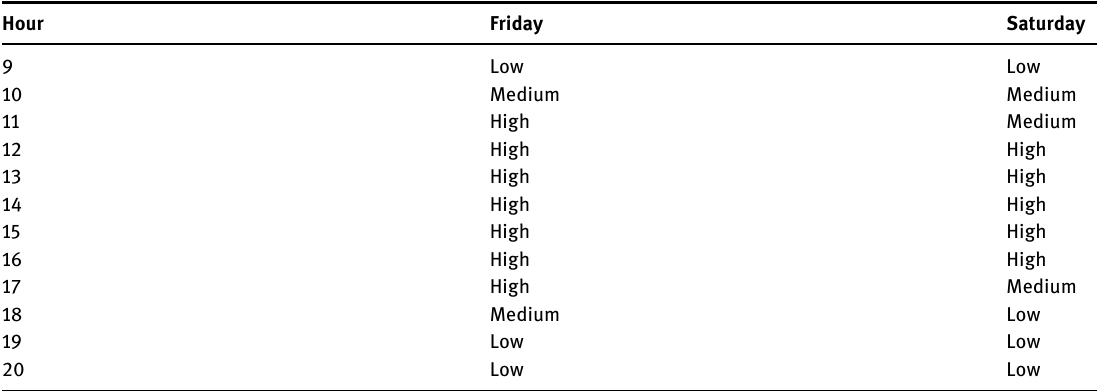
Table 3: Hourly level data during weekday and